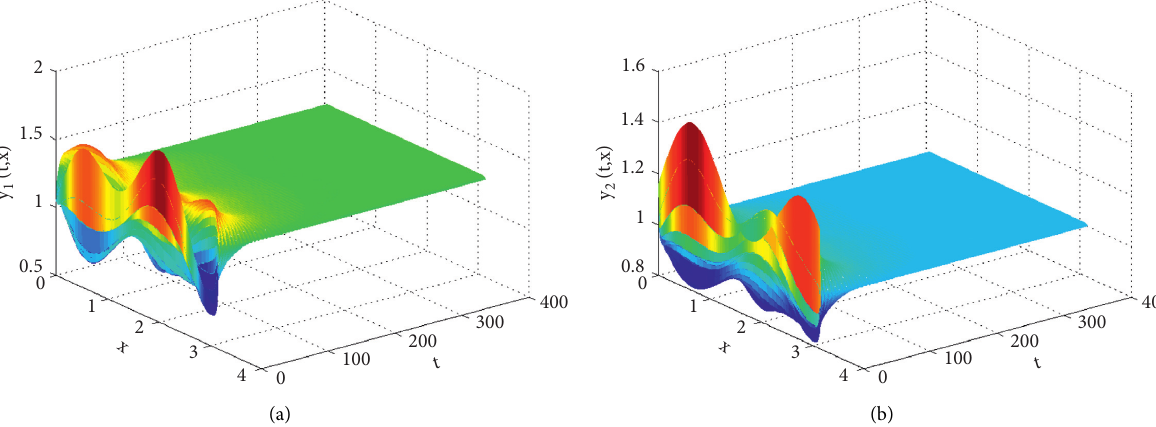
Figure 5: The positive constant steady state of the system with Dirichlet boundary is locally asymptotically stable for τ + τ � 2 . 3633. (a) Spatial distribution of y τ � τ < τ 0 1 2 0